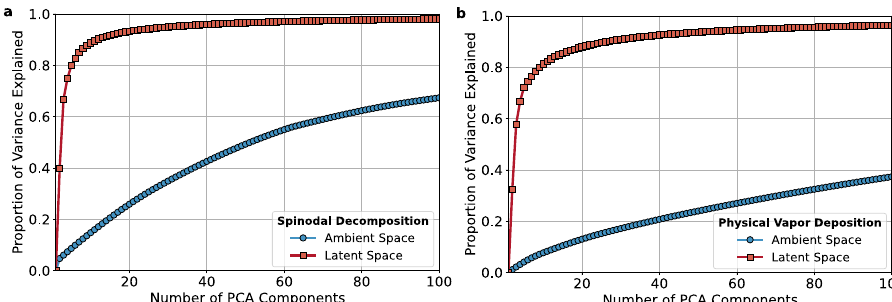
Fig. 3 Cumulative explained variance versus ranked principal components when using PCA directly on actual microstructure images (ambient space) or on latent representation (latent space). a Explained variance for the spinodal decomposition problem. b Explained variance for the physical vapor deposition problem. Ambient space denotes dimensionality reduction when PCA is performed directly on the high-dimensional microstructure images, while latent space denotes the projection when PCA is performed on the already compact representation of the microstructures obtained from the ResNet